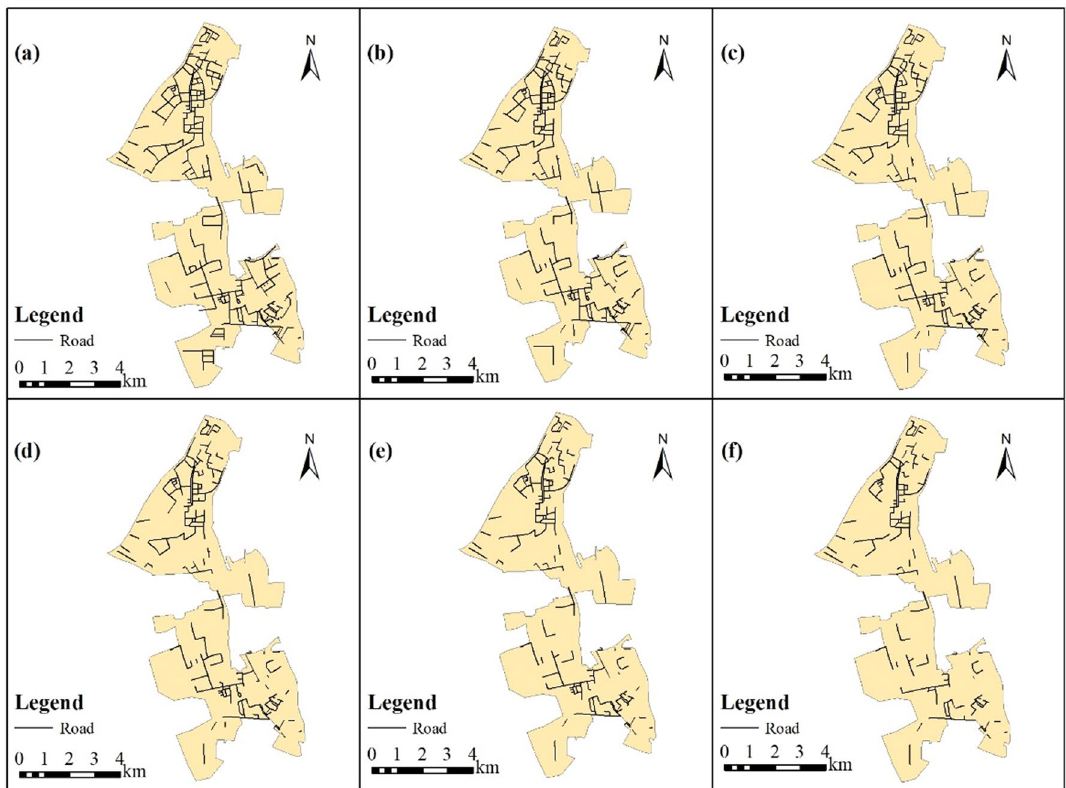
Figure 9. Un-flooded road network under different rainfall scenarios: ( a ) Rainfall Return Period = 2a; ( b ) Rainfall Return Period = 5a; ( c ) Rainfall Return Period = 10a; ( d ) Rainfall Return Period = 20a; ( e ) Rainfall Return Period = 50a; ( f ) Rainfall Return Period = 100a. This map was generated with ArcMap Version 10.0. (https:// www. esri. com/ en- us/ arcgis/ produ cts/ arcgis- deskt op/ overv iew).